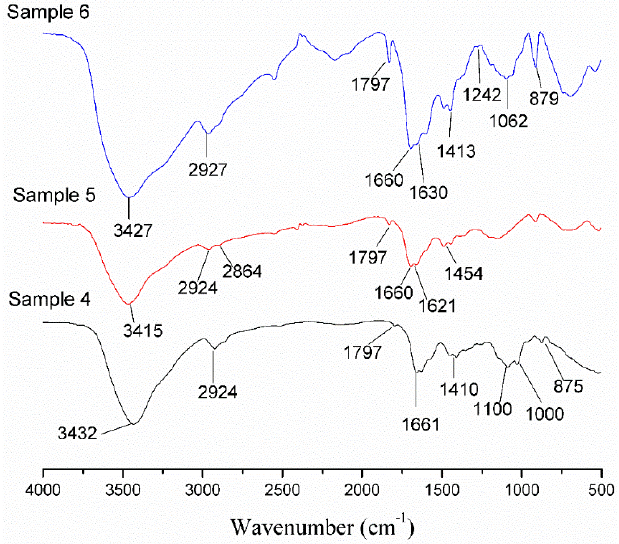
Figure 5. Infrared spectrum analysis of SFPDF containing the GC treatment agent.